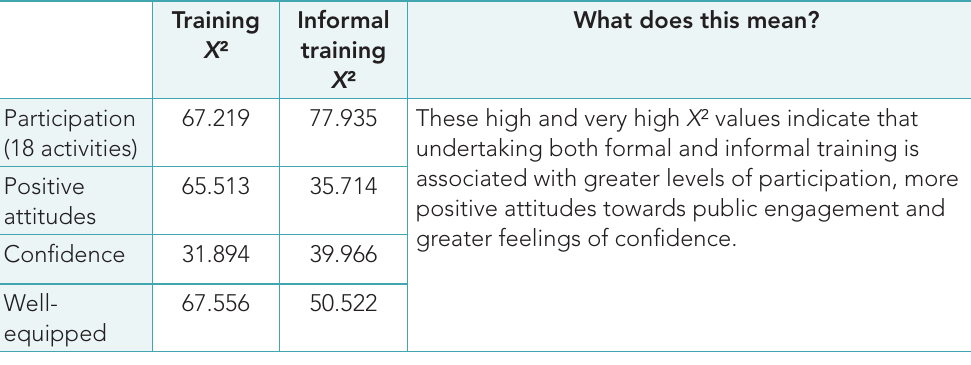
Table 10: Differences in outcome between the presence and absence of formal and informal training (all p -values are .000) (As described in Box 3, higher X ² values denote greater differences between the two groups of researchers, i.e. those who have participated in training and those who have